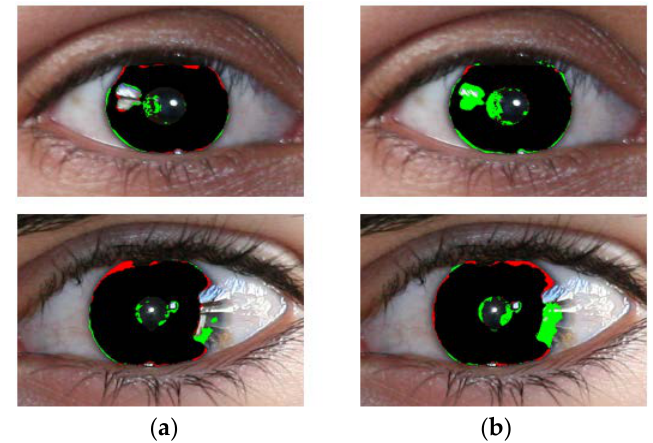
Figure 23. Comparisons of iris detection affected by ghost effect. Segmentation results obtained by ( a ) IrisDenseNet and ( b ) SegNet.